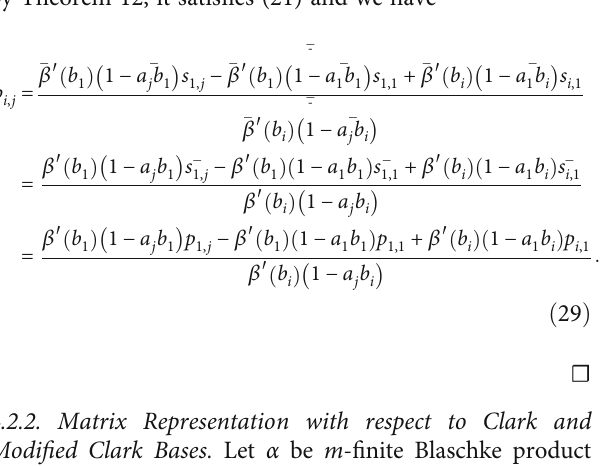
ffiffiffiffiffiffiffiffiffiffiffiffiffiffiffiffi (cid:12) β ′ ζ ð Þ (cid:12) 1 ffiffiffiffiffiffiffiffiffiffiffiffiffiffiffi (cid:12) β ′ ζ ð Þ (cid:12) i